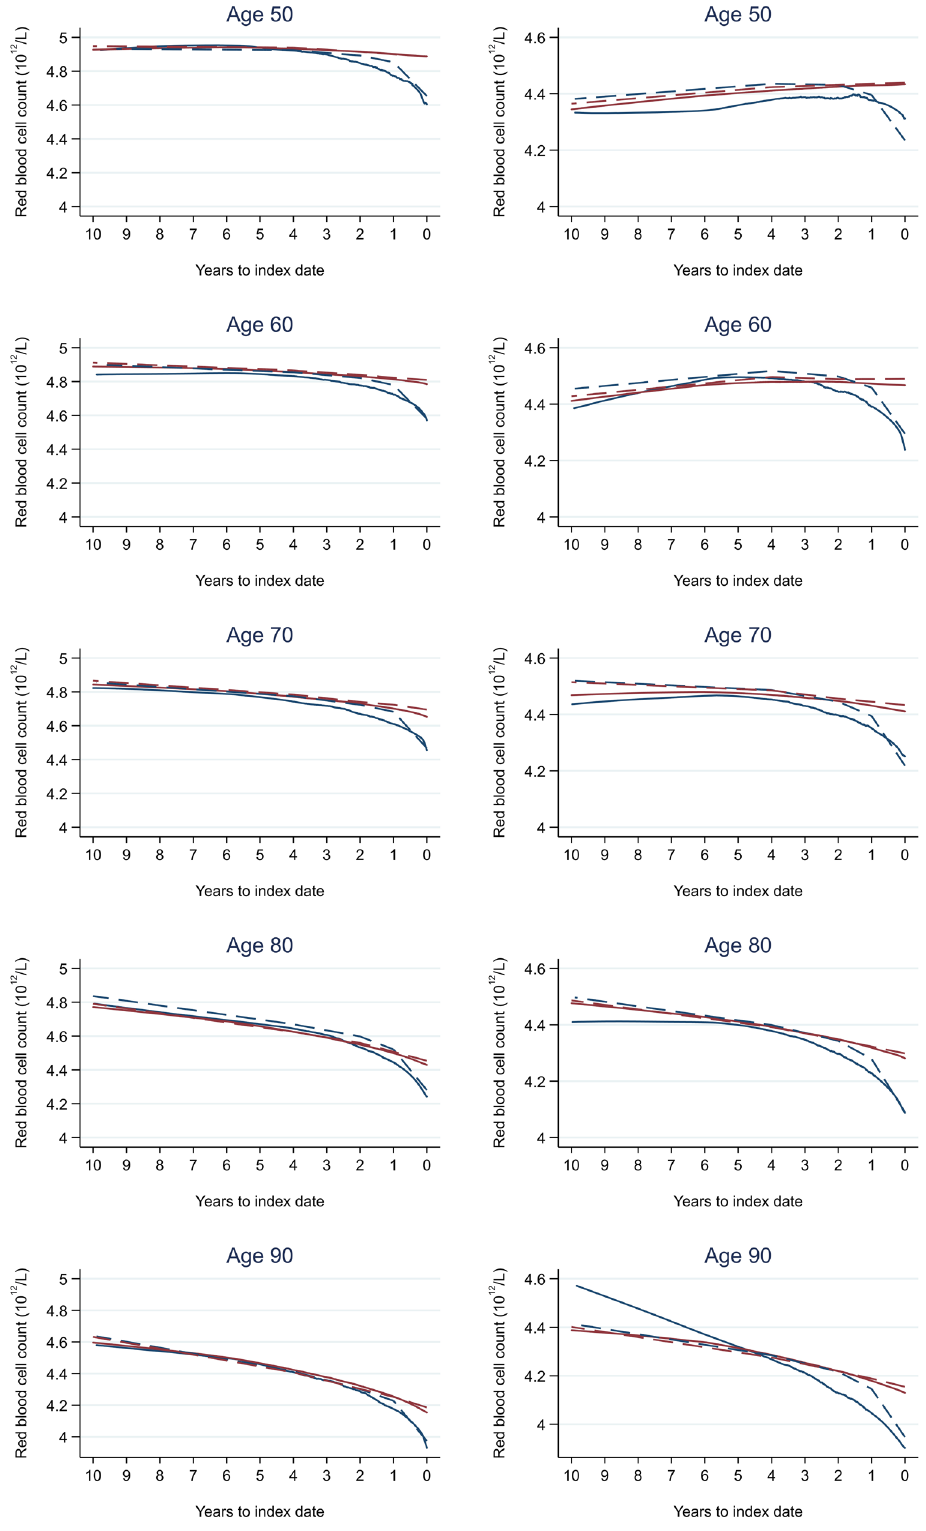
Figure 4. Red blood cell count trends between cases and controls, by age at index date 1,2 . 1 Index date was the date of diagnosis for cases and a randomly selected date in the patient’s study period for controls. 2 LOWESS trends are age (+/- 3 years) and modelled (fixed effects) trends are taken at that specific age. Legend: males (left) and females (right). Colorectal cancer (blue line) and no cancer (red line). LOWESS trend (solid line) and modelled trend (dashed